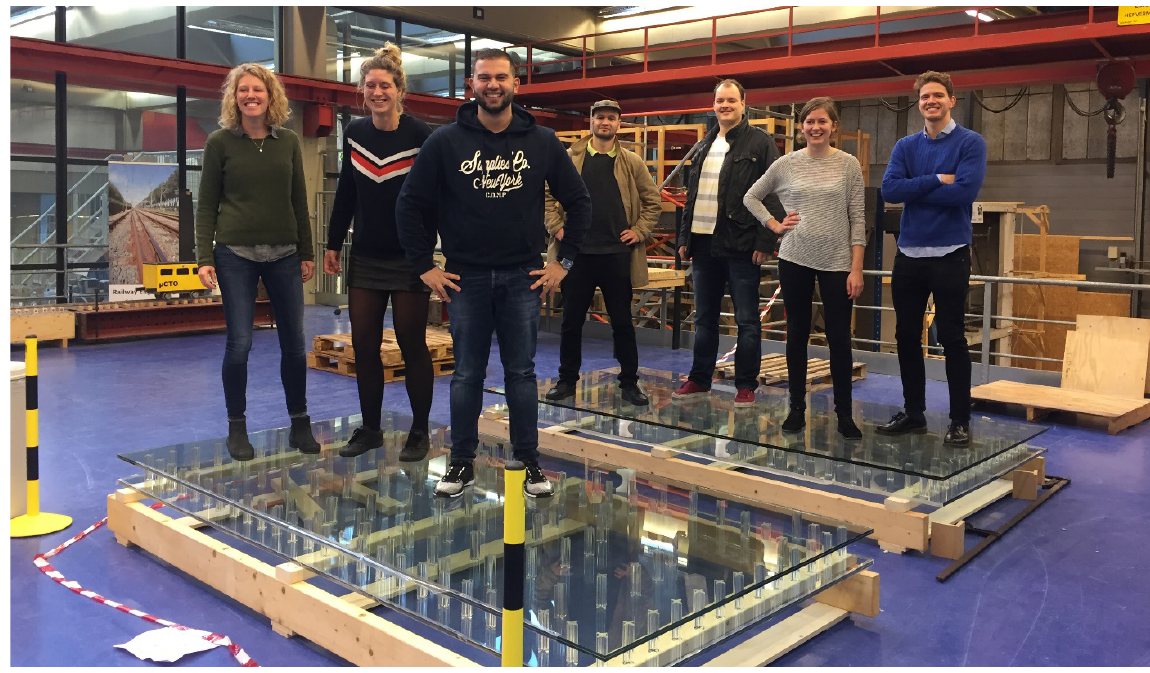
Fig. 20: 3x1.5m designed for the purpose of the Technoledge course at